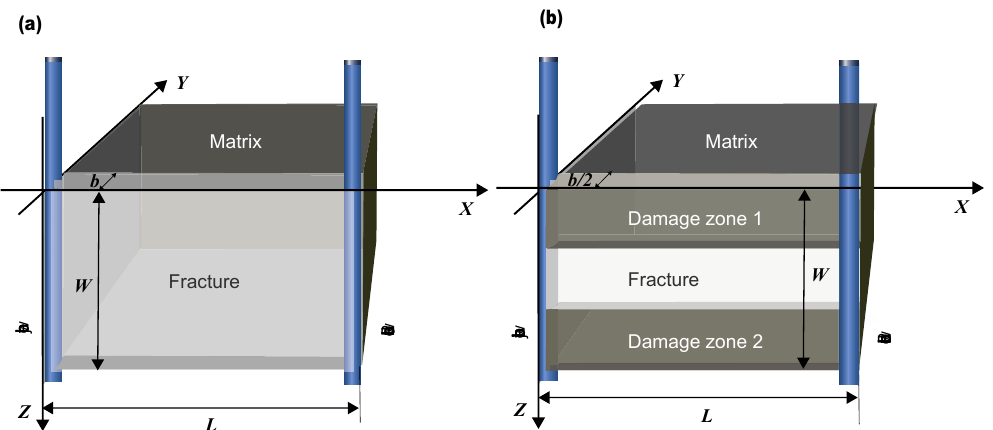
Figure 2. A schematic of the EGS reservoir: ( a ) uniform fracture and ( b ) three flow paths (a fracture surrounded by two damage zones). Table 1. Simulation properties in TOUGH2.